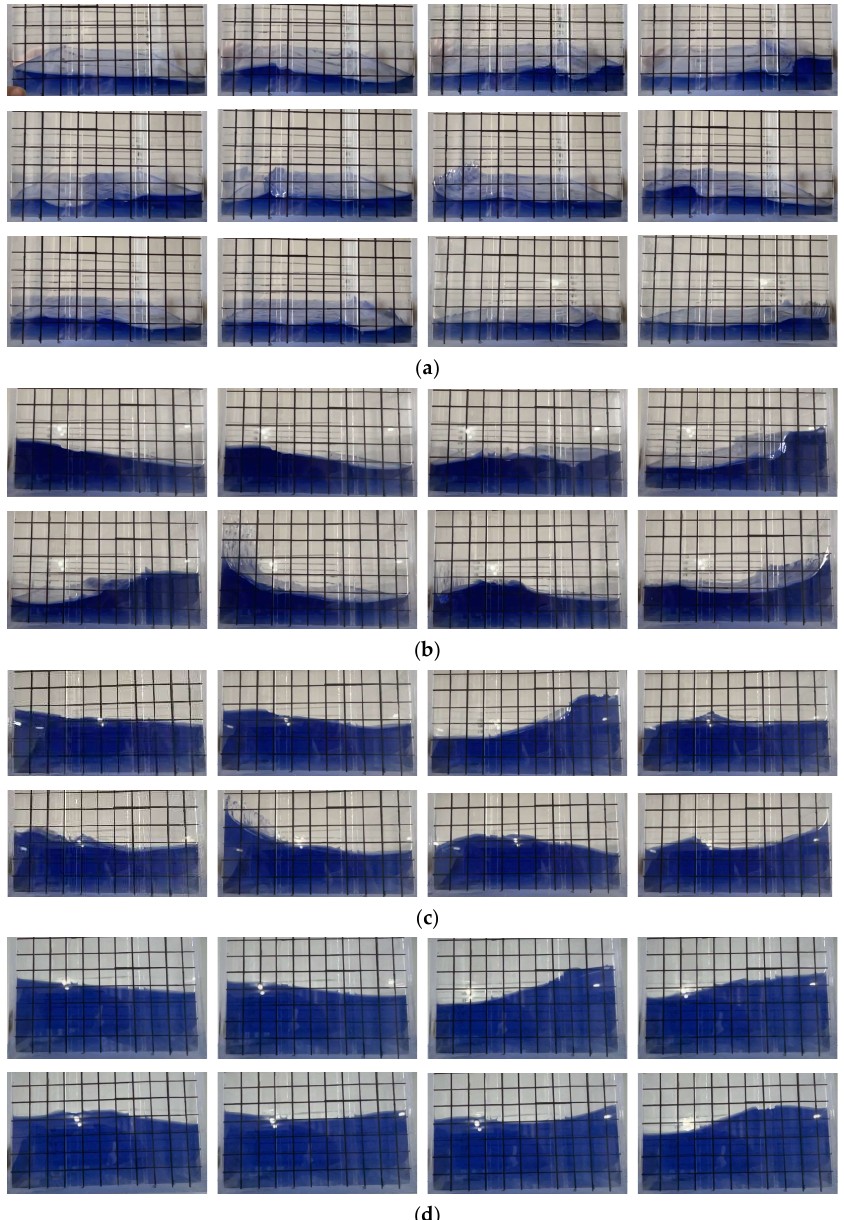
Figure 3. Water oscillation forms in sloshing process of different water levels. ( a ) Water level of 2 cm. ( b ) Water level of 4 cm. ( c ) Water level of 6 cm. ( d ) Water level of 8 cm.